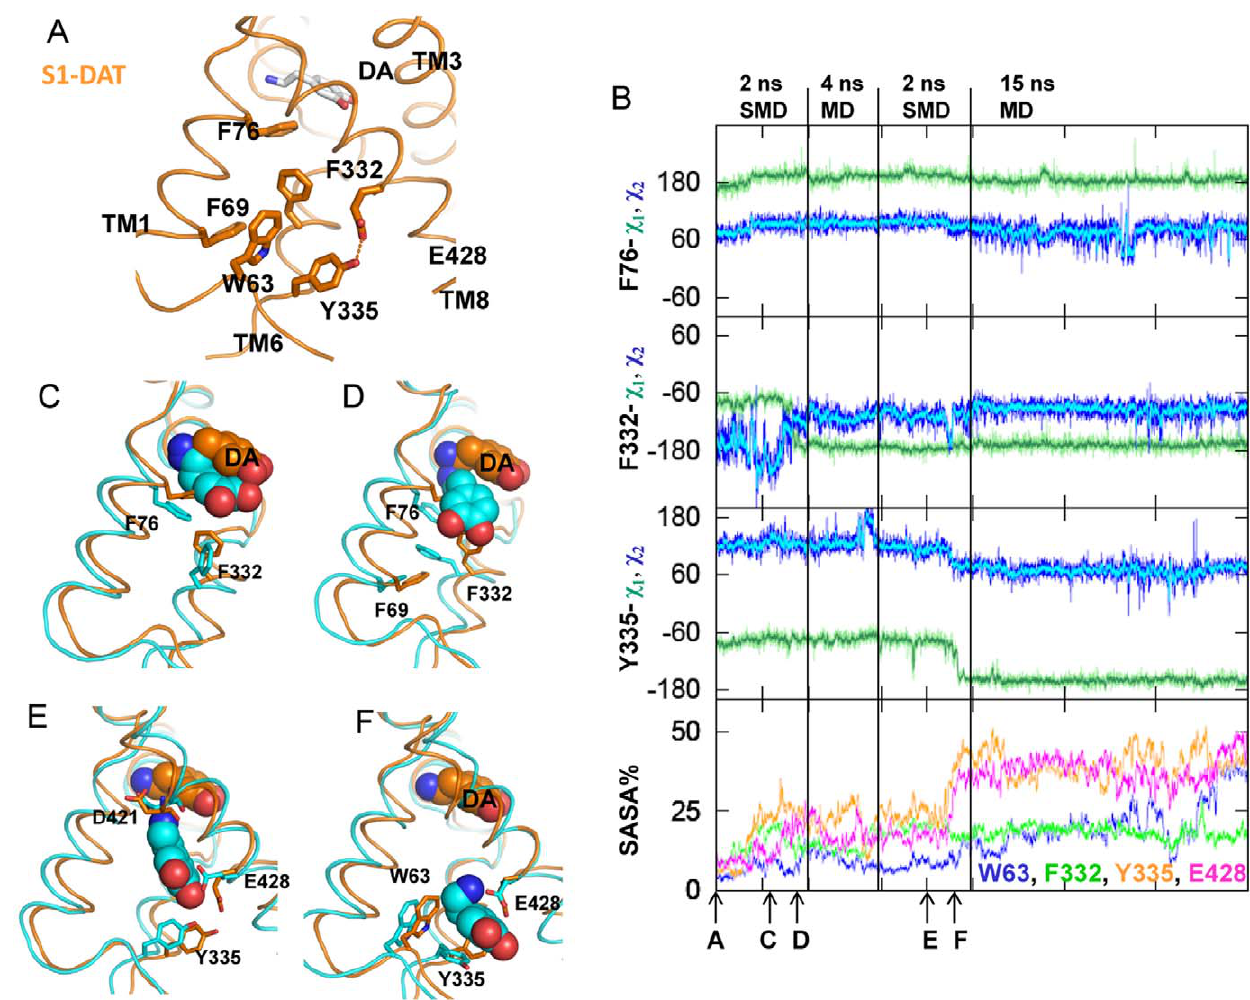
Figure 4. Conformational changes in the aromatic cluster during DA movement inward from the S1 site. ( A ) The cluster of aromatic residues from TMs 1 and 6 shown in S1-DAT is important for conformational transitions; DA in the S1 site is rendered in stick representation. Orange dashed line indicates H-bond of Y335 6.68 to E428 8.66 . ( B ) Time evolution of dihedrals and SASA (bottom panel) during inward pulling in SMD and MD alternation. Time points marked by the A, B, C, D, E, F arrows on the x-axis correspond to the structures shown in the ( A ) – ( F ) panels. The lines in the SASA plot are coded in colors corresponding to the residues names in the same colors. ( C ) The change in the rotamer of F76 1.42 from the conformation in S1-DAT (orange) to the configuration at the time point indicated by the C arrow in ( B ) (cyan), which allows the downward movement of DA. ( D ) The subsequent change in the rotamer of F332 6.65 (same color coding as in ( C )) as DA moves to the position originally occupied by the sidechain of F332 6.65 . ( E ) When DA is slowly pulled down a bit further in the SMD protocol, its amine forms a new H-bond with the carboxyl oxygen of D421 8.59 which coordinates Na2 in S1-DAT, and its hydroxyl groups forms H-bonds with the sidechain carboxyl group of E428 8.66 . Time is indicated by the E arrow in ( B ). ( F ) The rotamer of Y335 6.68 changes last, breaking the H-bond between Y335 6.68 and E428 8.66 . DA moves to the position originally occupied by the sidechain of Y335 6.68 and E428 8.66 . Time is indicated by the F arrow in ( B ).